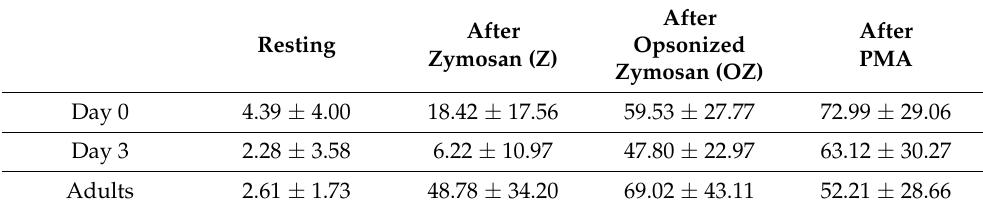
Table 2. Superoxide radical (SR) production in neonates (on day 0 and day 3) and in non- smoking adults. After After Resting Zymosan (Z)